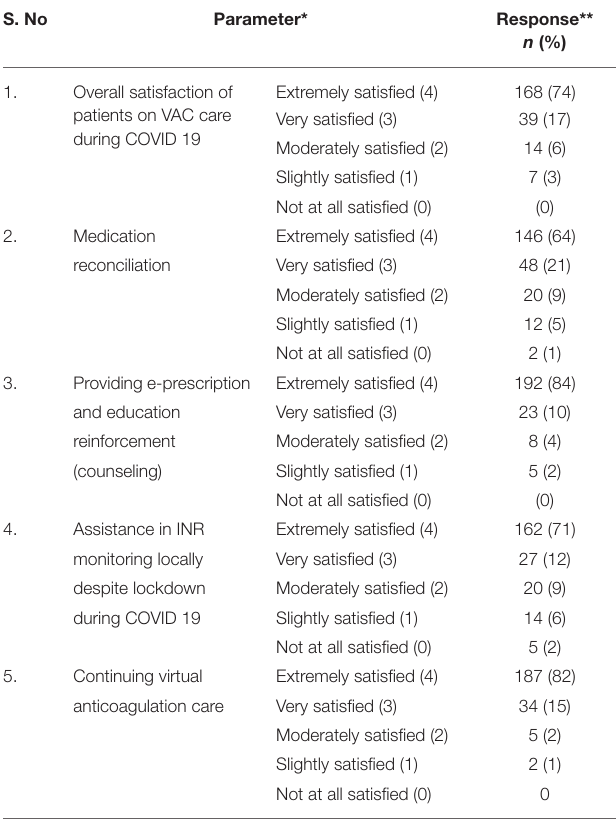
TABLE 4 | Patient satisfaction toward virtual anticoagulation care (VAC) during COVID-19 pandemic ( N = 228). S.